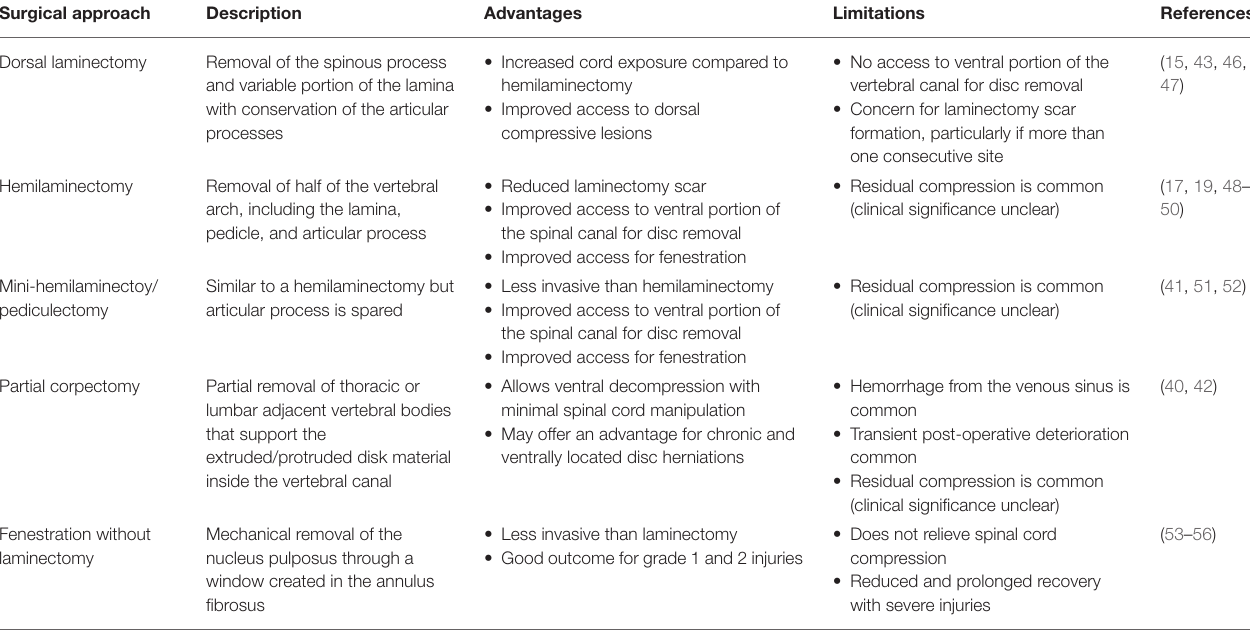
TABLE 4 | A summary of published surgical approaches and reported outcomes for canine acute intervertebral disc herniation (IVDH) affecting the thoracolumbar spine. Surgical